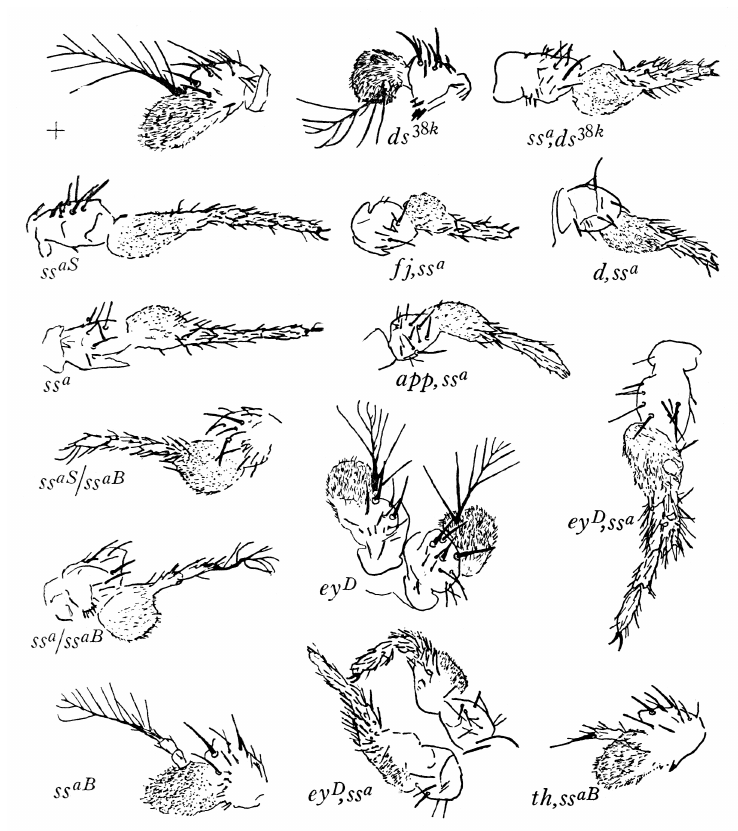
the conceptual development. This is an example of the productivity of images of analogical models.